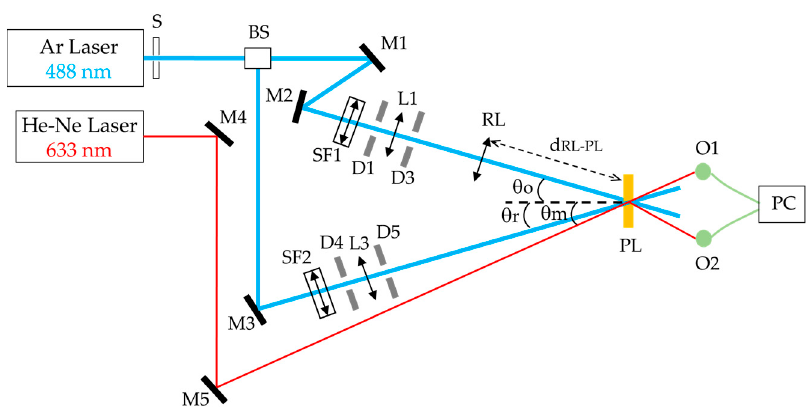
Figure 2. Experimental setup for recording of holographic lenses. S: electronic shutter, BS: beam-splitter, Mi: mirrors, Li: lenses, Di: diaphragms, SFi: spatial filters, RL: refractive lens, PL: photopolymer layer, Oi: optical power meters, PC: data recorder. Table 1. Recording parameters of the holographic lense (HL).